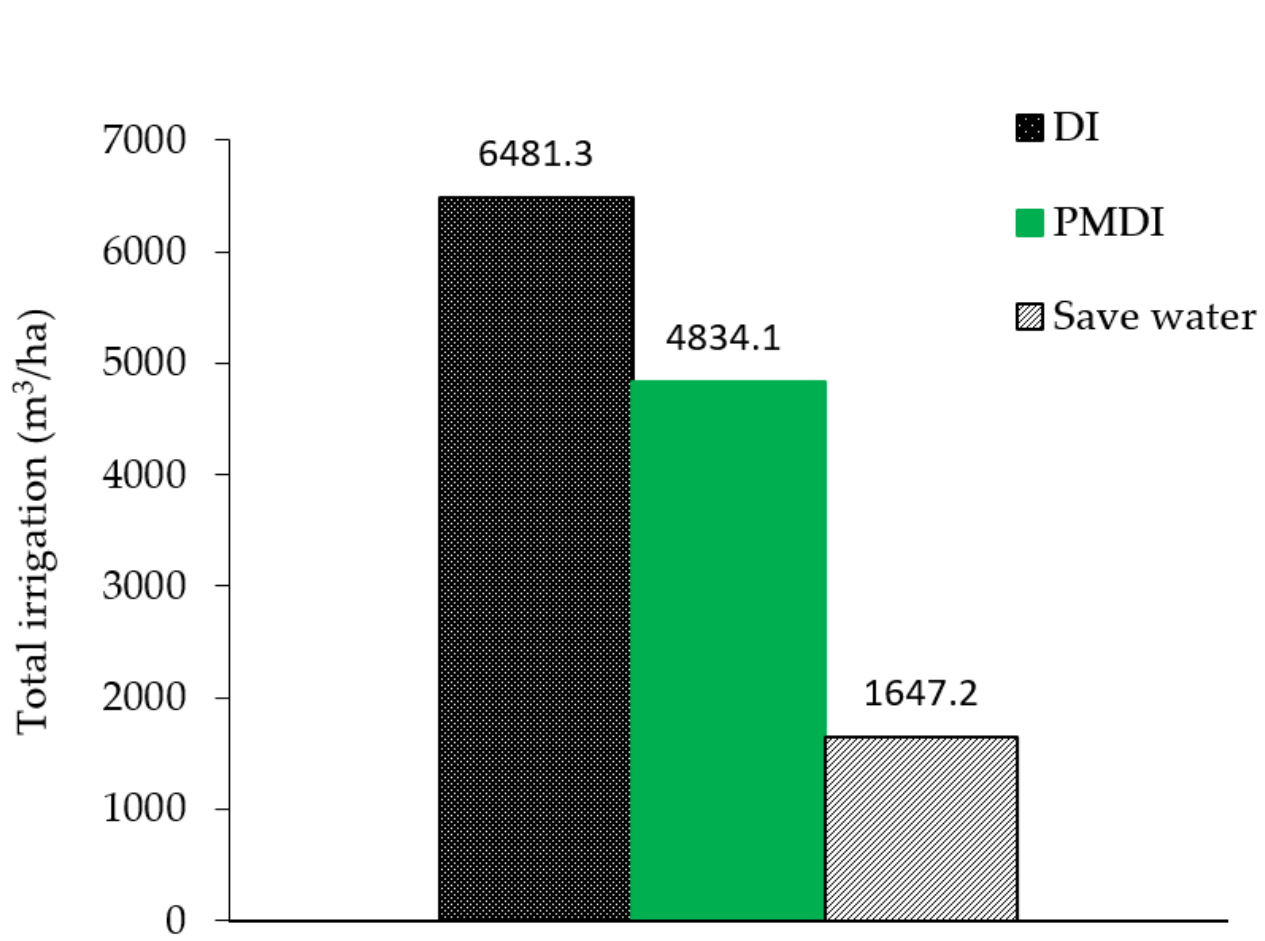
Figure 6. Comparison of total applied water in research treatments.